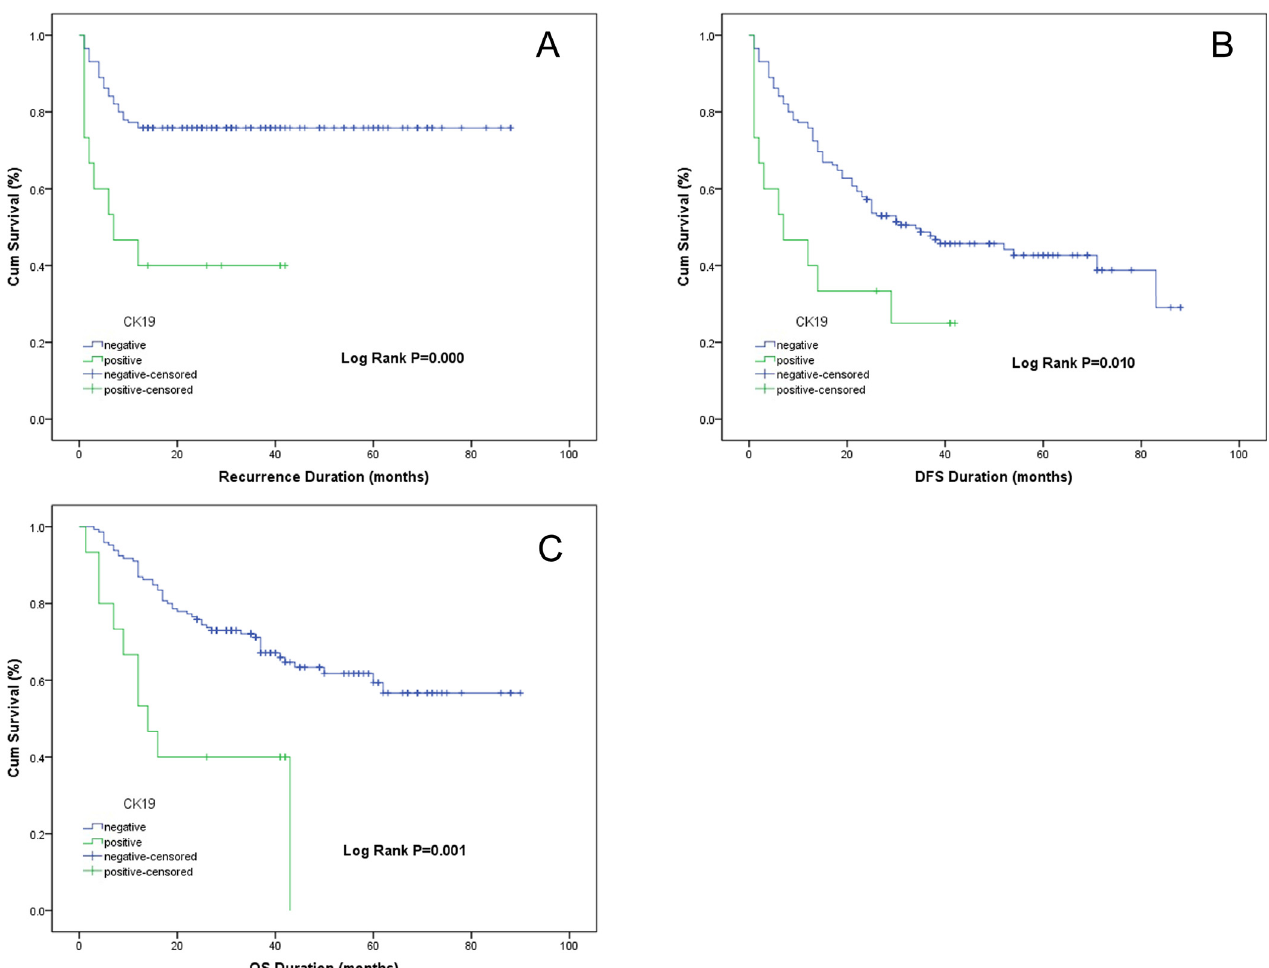
Fig 4. Kaplan – Meier curves based on CK-19 expression level. (A) Early recurrence disease-free survival curves. (B) Disease-free survival curves. (C) Overall survival curves. (A) Early recurrence rate in CK-19 + patients was significantly higher than that in CK-19 – patients (log-rank test P = 0.000). Survival of CK-19 + patients was significantly shorter than that of CK-19 – patients (DFS: log-rank test P = 0.010; OS: log-rank test P =